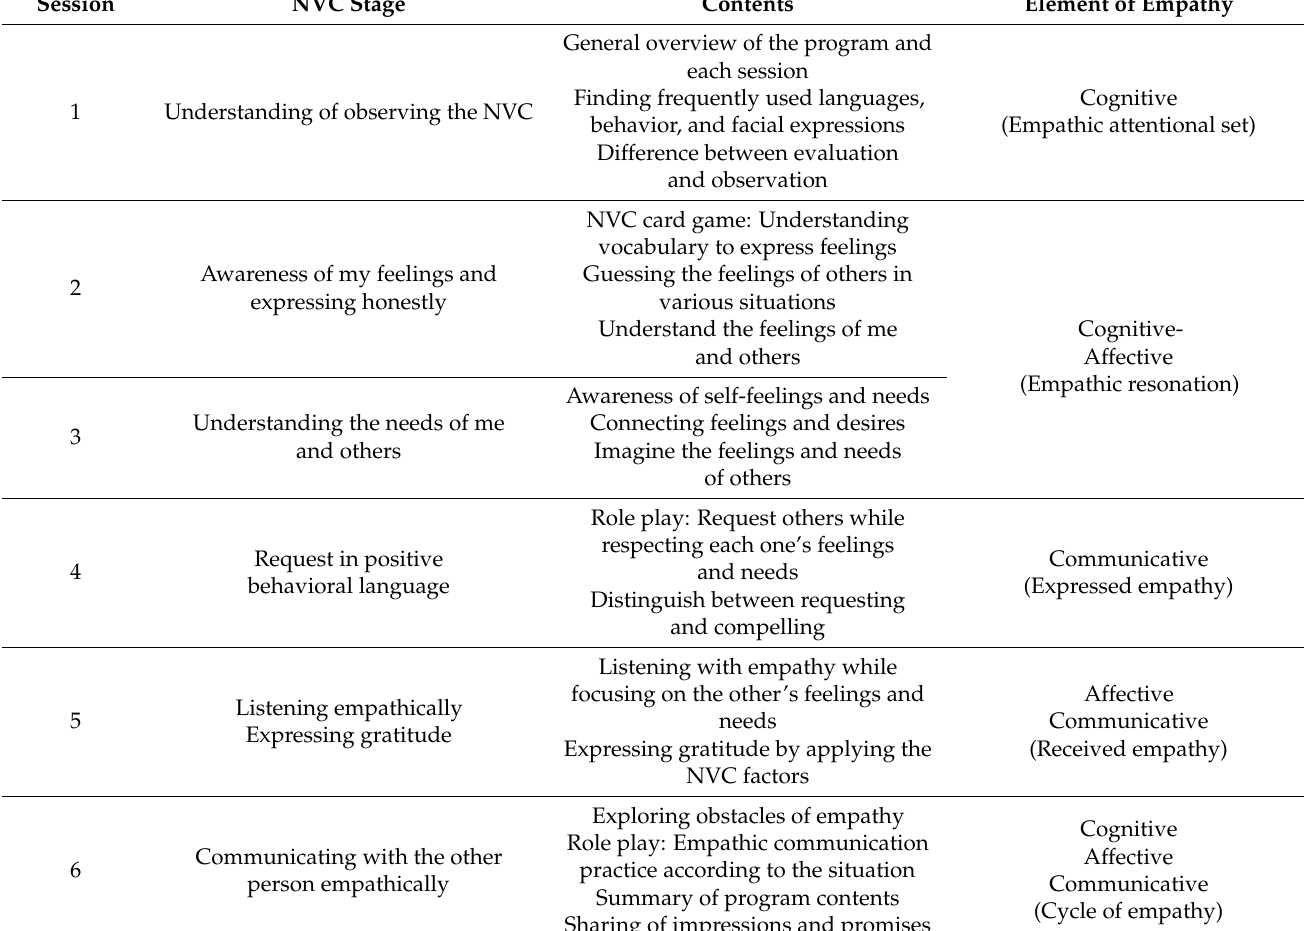
Table 1. Nonviolent communication empathy education program based on cyclical empathy